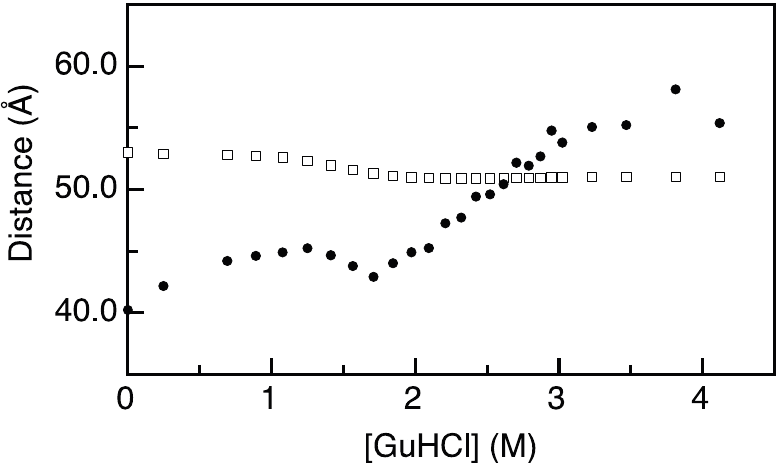
Figure 4. The distance between donor and acceptor fluorophores changes as a function of denaturant concentration and reveals conformational changes during apoflavodoxin (un)folding. The Förster transfer distance ( R 0 ; open squares) changes as a function of denaturant concentration in a folding state-dependent manner. Calculated distances ( r da ; black dots) between donor Alexa Fluor 488 and acceptor Alexa Fluor 568 track the features of apoflavodoxin (un)folding. Values of R 0 are obtained by using parameters as described in Supplementary Information SI3. Values of r da are obtained by using Equation